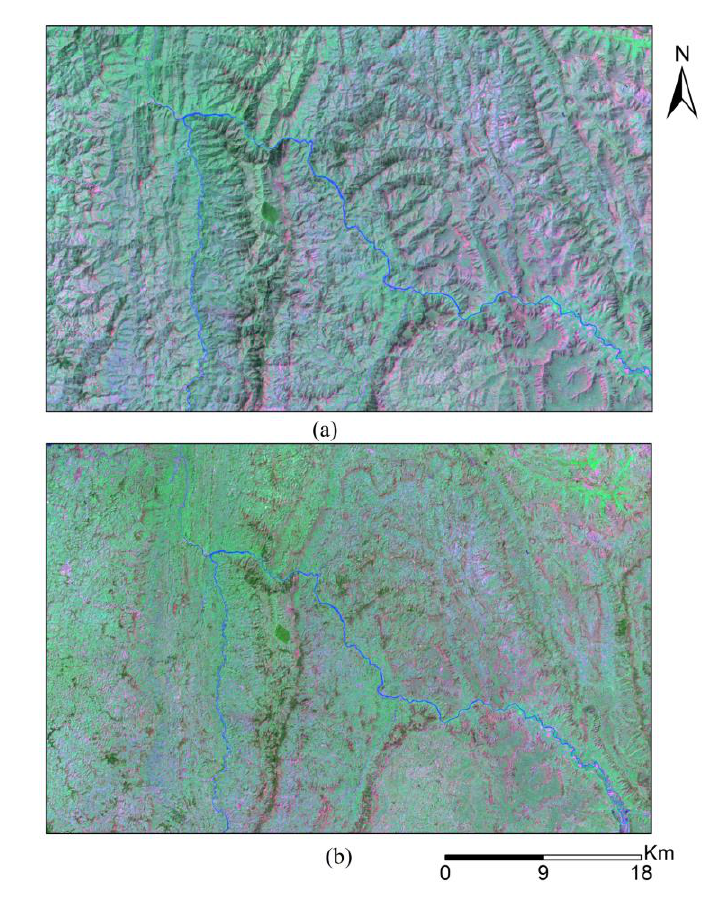
Figure 4. Landsat color composite (2001) of a hilly region in Rwanda (lat −1.81, lon 29.76; RGB = TM bands 7,4,2) ( a ) before illumination compensation; and ( b ) after illumination